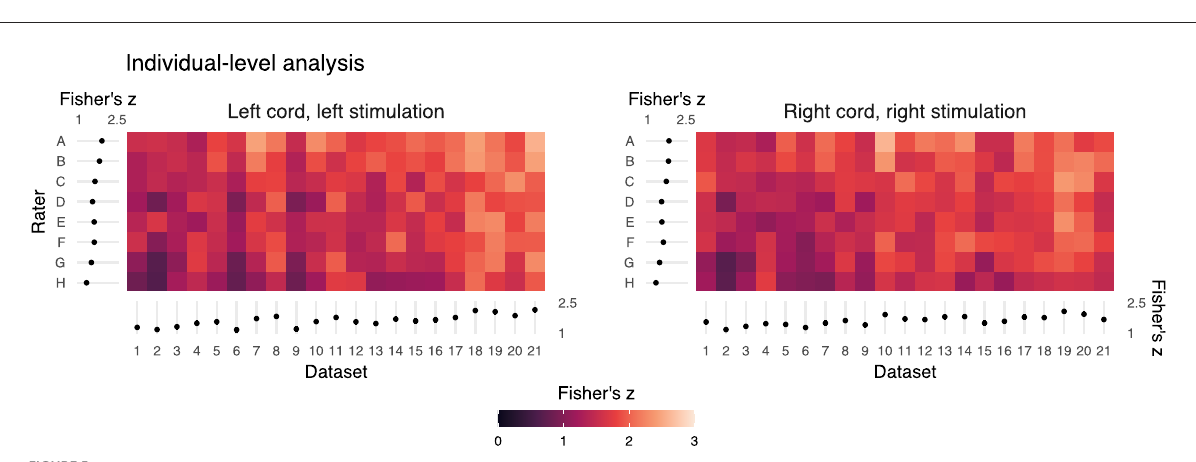
FIGURE5 Summary of the individual- (or dataset-) level activation maps. Spatial correlation of statistical activation maps derived from the individual-level analysis results of each rater and the reference, for ipsilateral activation of left- and right-sided stimulation trials. Results shown as a color map of Fisher’s z correlations between rater and reference un-thresholded statistical activation maps, with the dataset order matching Figures 2 and 4. The horizontal and vertical gradient trends indicate that rater agreement with the reference mask and dataset factors influence agreement with the reference individual-level statistical activation maps. Marginal mean Fisher’s z scores by dataset and rater are shown at the axes. Error bars on the marginal means indicate 95%